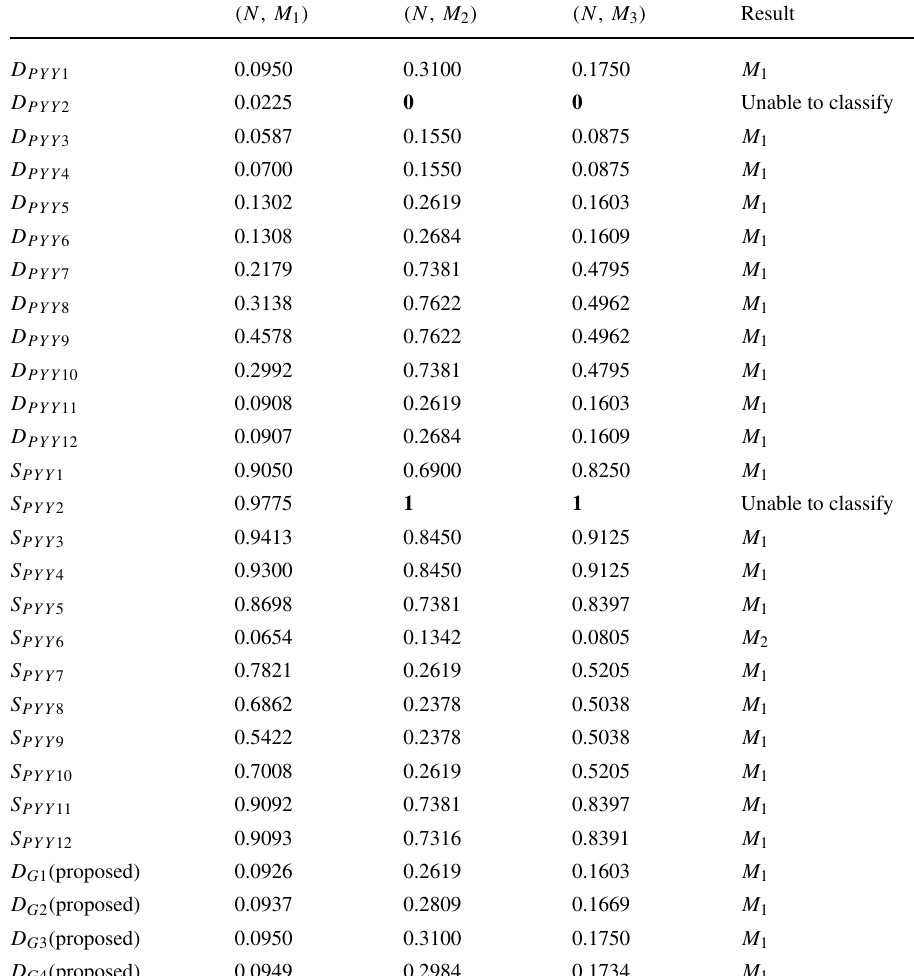
Table 9 Computed values of distance/similarity between the unknown pattern and known patterns regarding Example